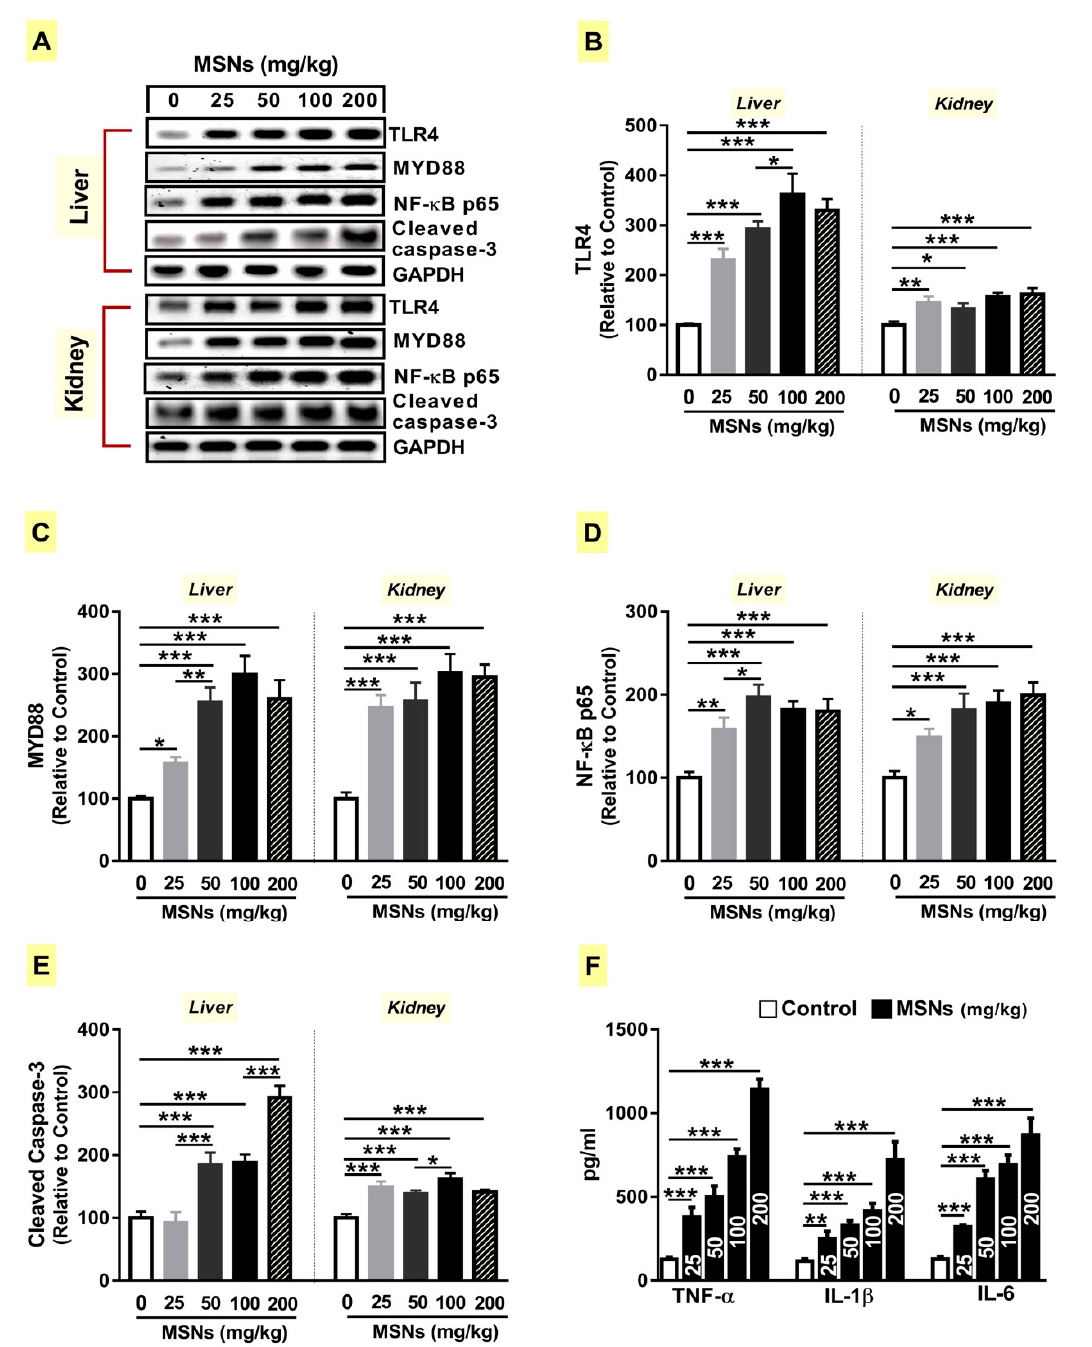
Figure 5. MSNs activate TLR4 / MyD88 / NF- κ B signaling and apoptosis in the liver and kidney of rats. ( A ) Representative blots of TLR4, MyD88, NF- κ B p65, and cleaved caspase-3. MSNs up-regulated TLR4 ( B ), MyD88 ( C ), NF- κ B p65 ( D ), and cleaved caspase-3 ( E ), and increased levels of serum TNF- α , IL-1 β , and IL-6 ( F ). Data are mean ± SEM ( n = 6). * p < 0.05, ** p < 0.01, and *** p < 0.001.